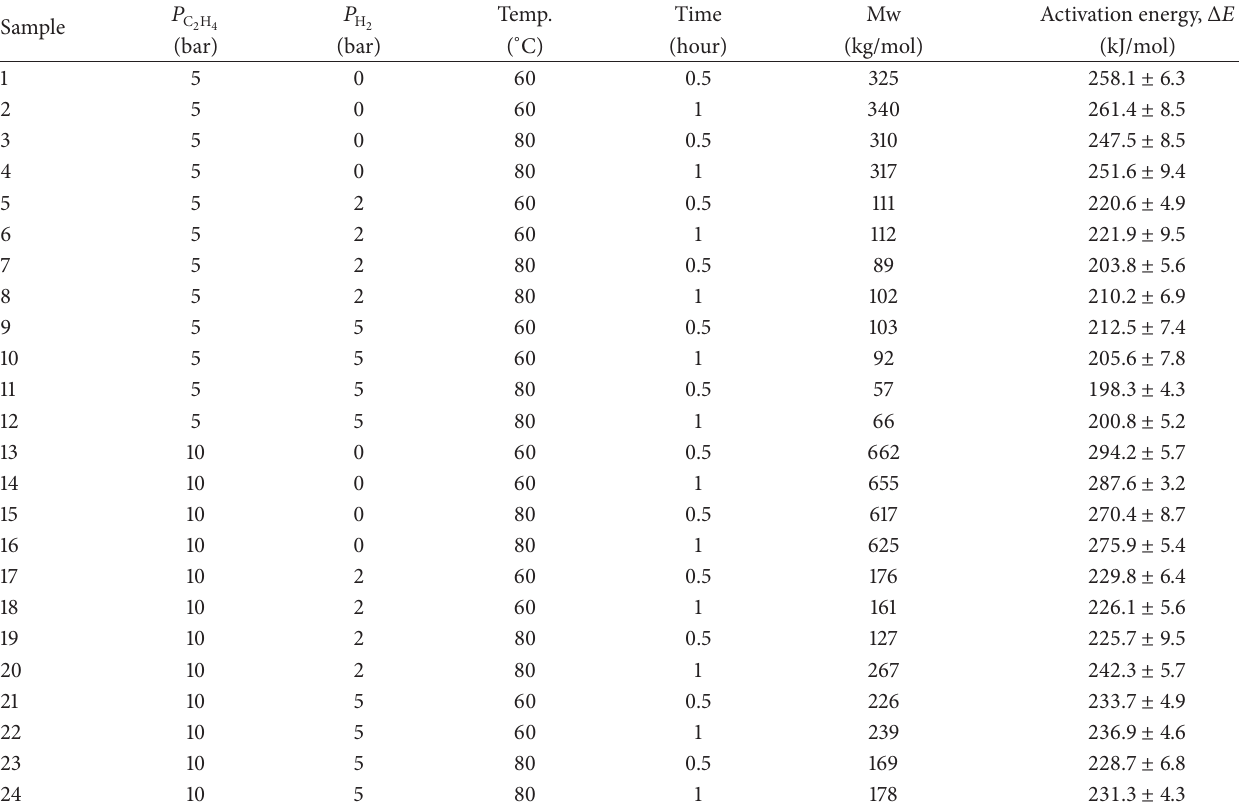
Table 2: Activation energy for polyethylene